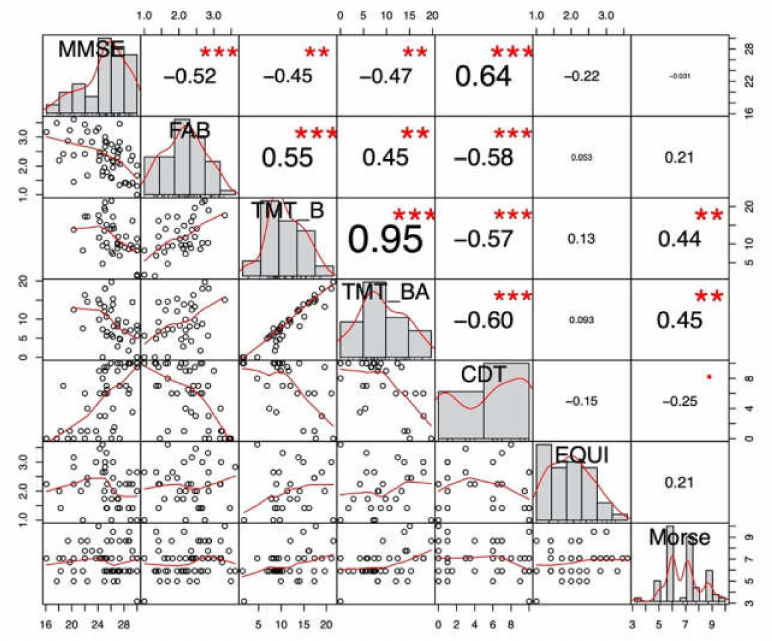
Figure 1. Non-imputed global cognition and executive functions correlations with physiotherapy measures. CDT: Clock Drawing Test; CTD: Cancellation Test of Digits; FAB: Frontal Assessment Battery; MMSE: Mini-Mental State Examination; TMT: Trail Making Test. *** p < 0.001; ** p < 0.001; * p < 0.05; p <